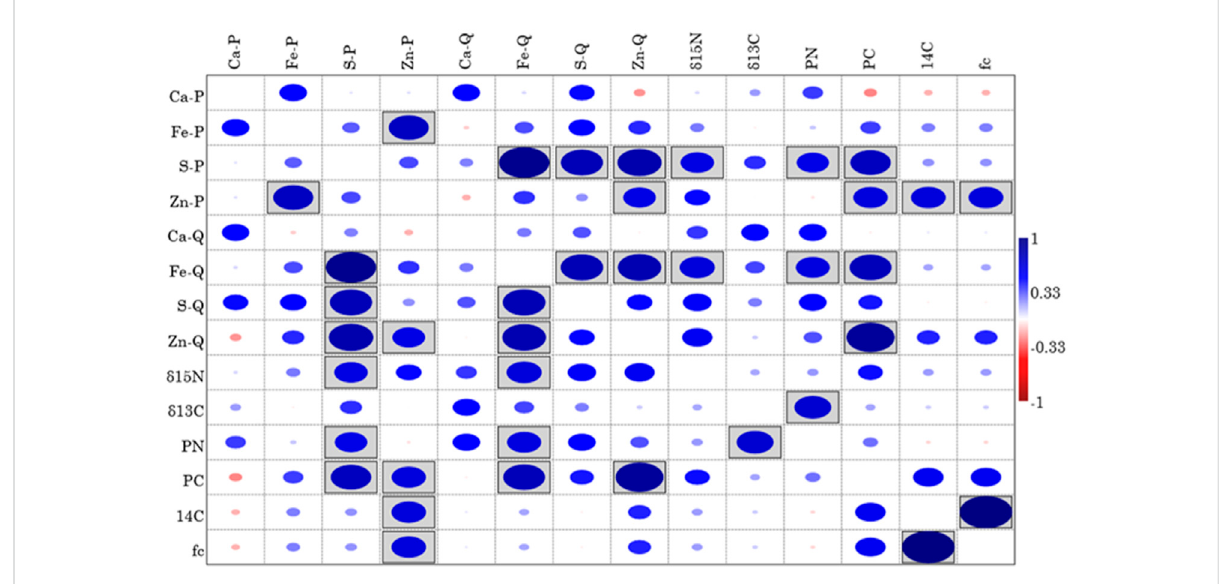
FIGURE 3 Color plot based on the Spearman correlation coef fi cients (positive coef fi cients are in blue, while negative coef fi cients are in red). The boxed circles represent theSpearman coef fi cients signi fi cant ata p -level < 0.05. The input variables are theCa, Fe, S,and Znconcentrations determined by PIXE using both PTFE (P) and quartz (Q) fi lters, in addition to the stable isotope measurements of nitrogen and carbon ( δ 15 N and δ 13 C, respectively), particulate nitrogen and carbon content (PN and PC, respectively), amount of 14 C expressed in a unit of percent modern carbon (pMC), and the contemporary carbon fraction f c